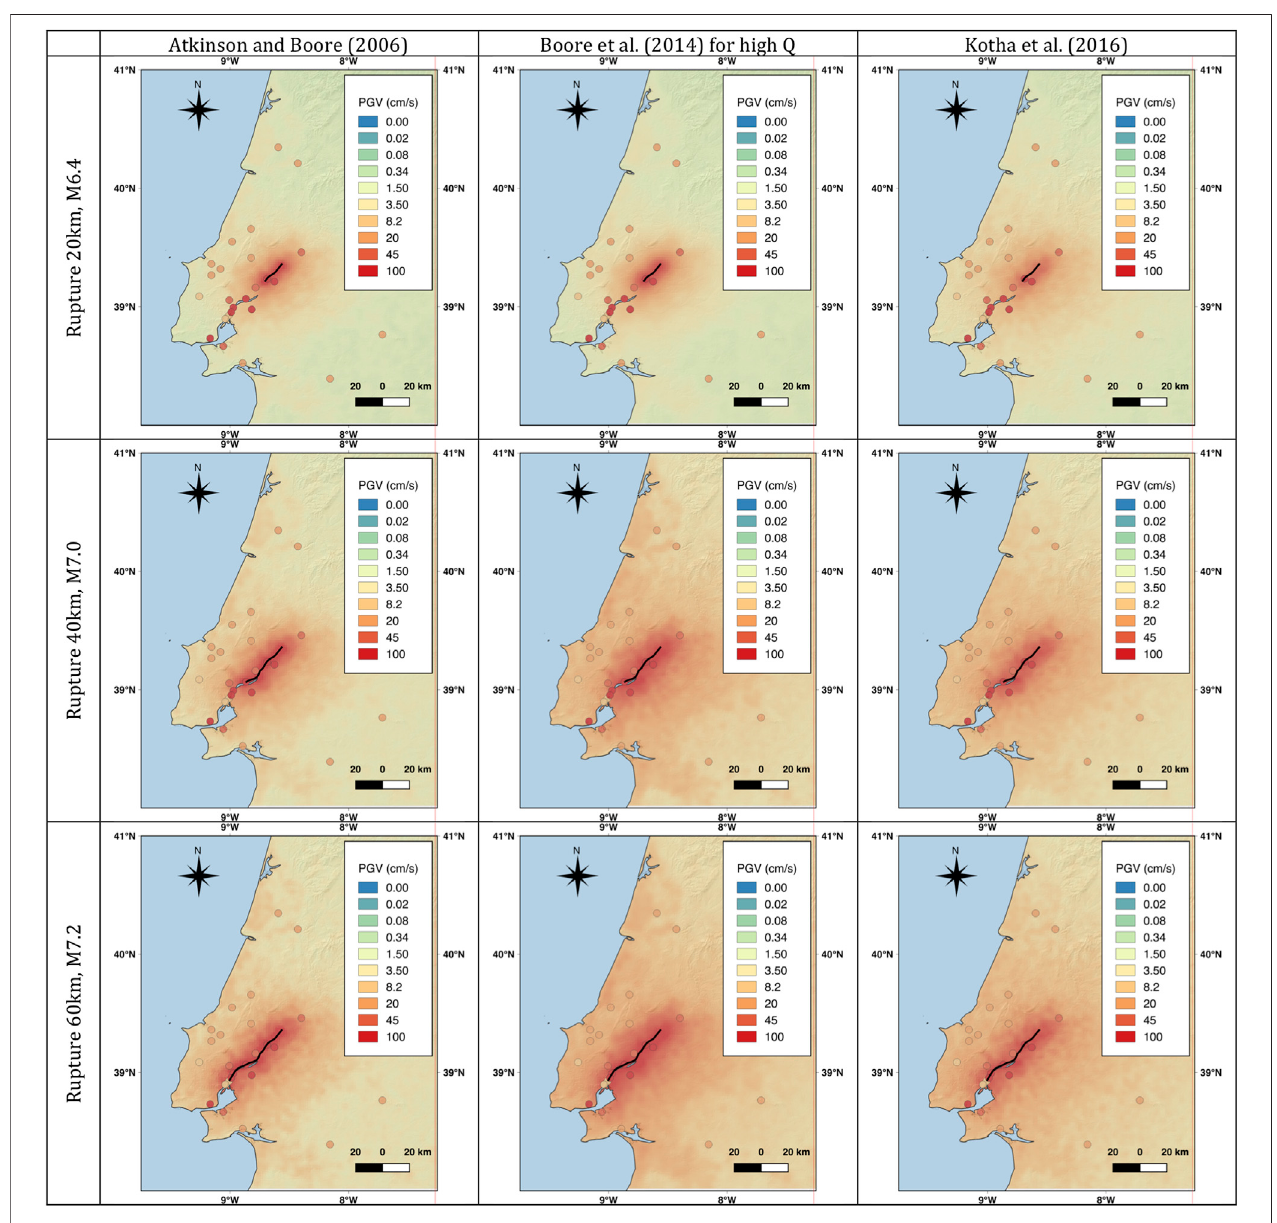
FIGURE10| PGVScenariocalculationsforhypotheticalrupturesalongtheLTVFZ,includingtheAlvielatrenchsite(locatedatthenorthernmostpartoftherupture). The macroseismic intensity dataset for the 1531 according to Justo and Salwa (1998) converted toPGV through the Caprio et al.(2015) relationship for Italy isincluded.